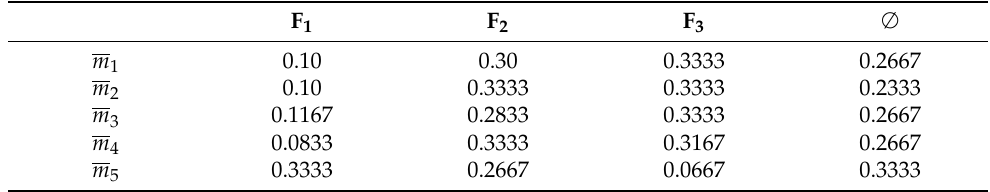
Table 2. Negation of BPAs of